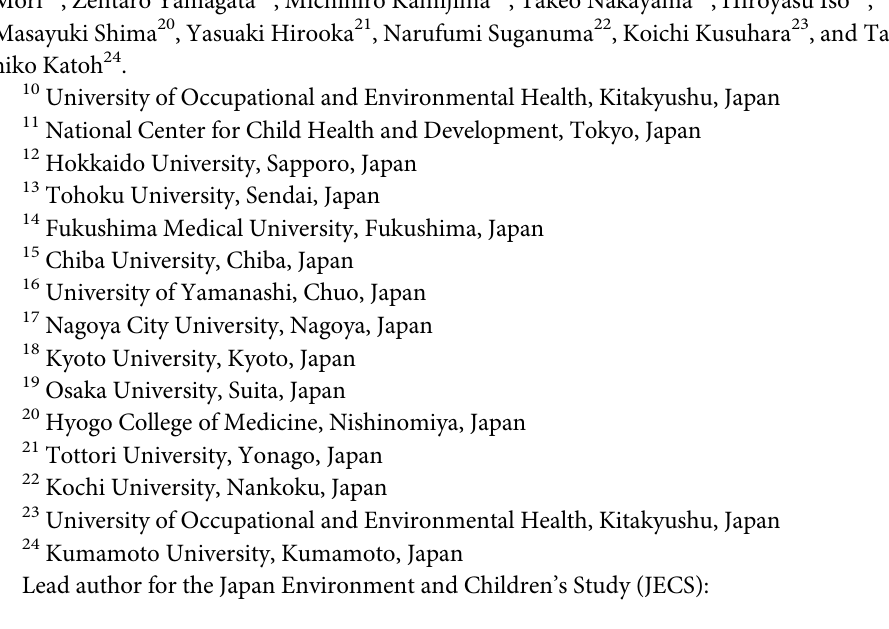
S4 Table. Association between physical activity level before pregnancy and mode of deliv- ery. � p <